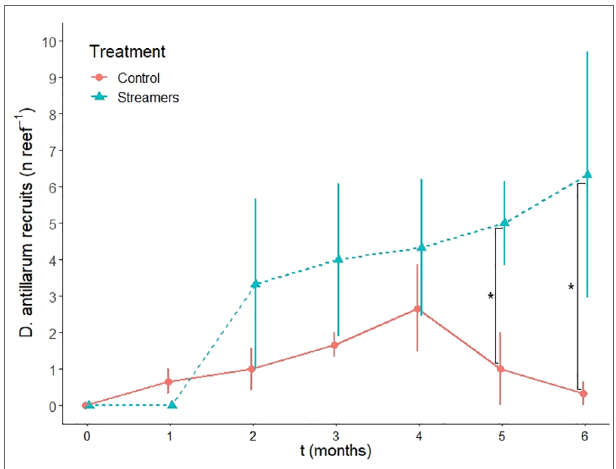
FIGURE 5 | D. antillarum density on treatment (with streamers) and control (without streamers) reefs as a function of time. Lines connect averages ± SE and * indicates a significant difference in treatments for that month.